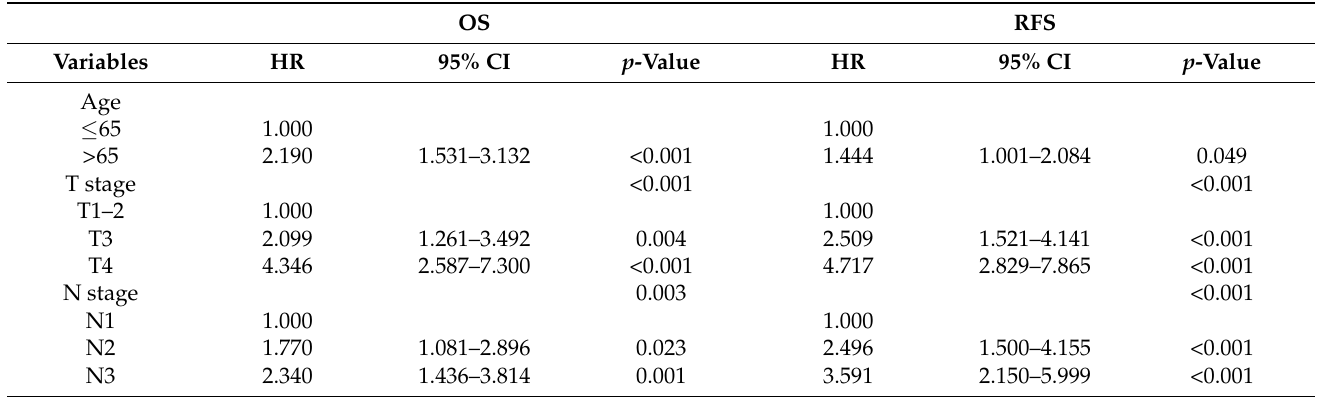
Table 4. Multivariate Cox regression analysis for OS and RFS in all patients ( n = 692).